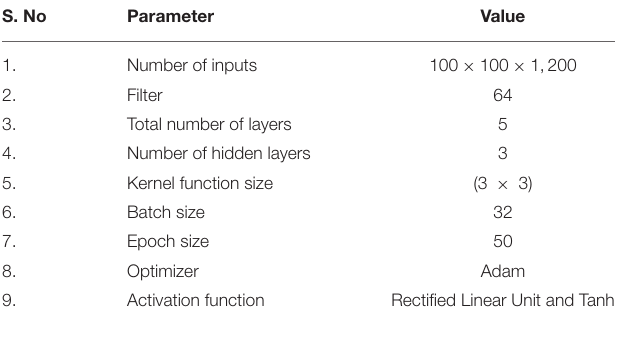
TABLE 2 | Set of parameters defined for the proposed hybrid model.